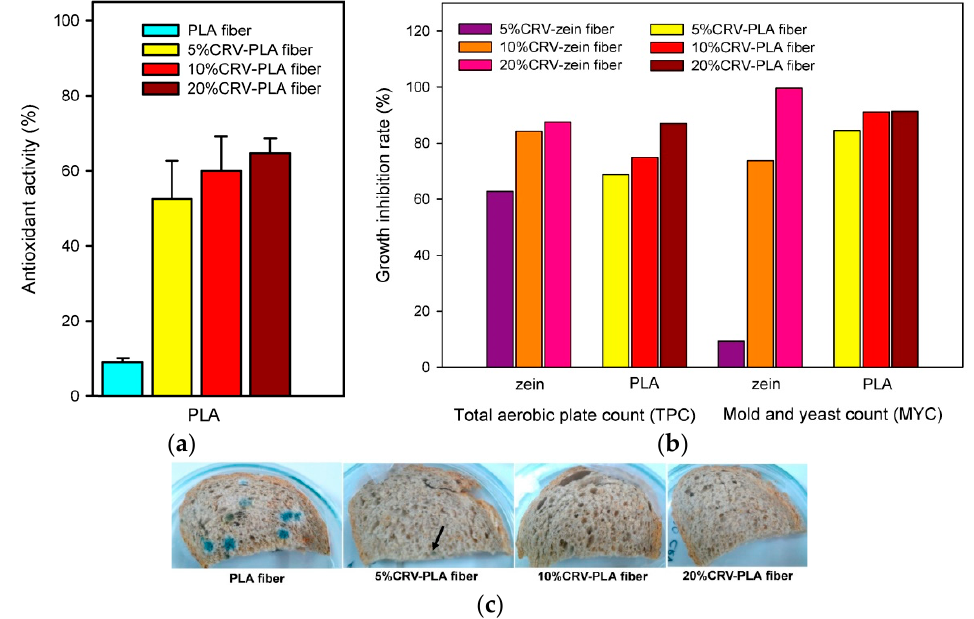
Figure 11. Antioxidant activity (%) of electrospun fibers of PLA with different carvacrol content ( a ); growth inhibition rate (%) of aerobic bacteria and mold and yeast of zein and PLA electrospun fibers ( b ); and images of whole wheat bread samples packed with electrospun PLA fibers with different carvacrol content stored at 25 °C for 7 days ( c ). Reprinted with permission from Ref. [144], Copyright 2018 Elsevier